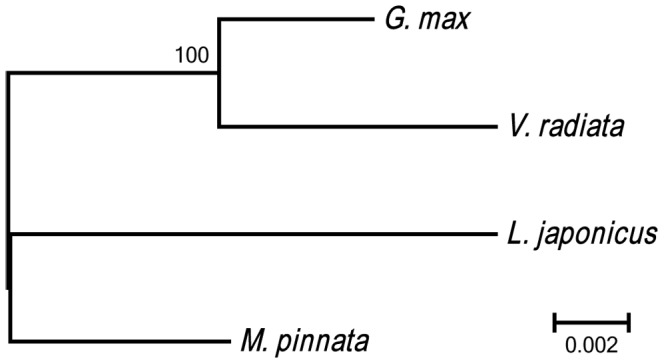
Phylogeny of four Faboideae mitochondrial genomes.Numbers above each node represent bootstrap values from 1000 replicates. Branch lengths are in units of synonymous substitutions per synonymous site.